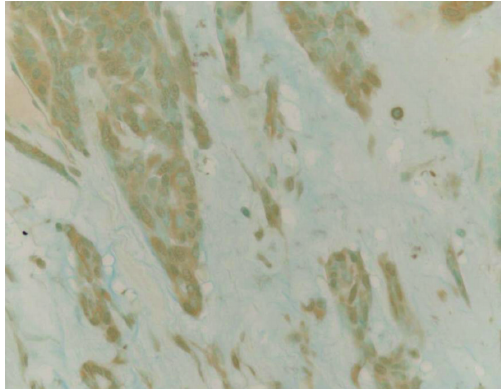
Figure 3: Showing moderate p53 staining in pleomorphic salivary adenoma. Original magnification x40.